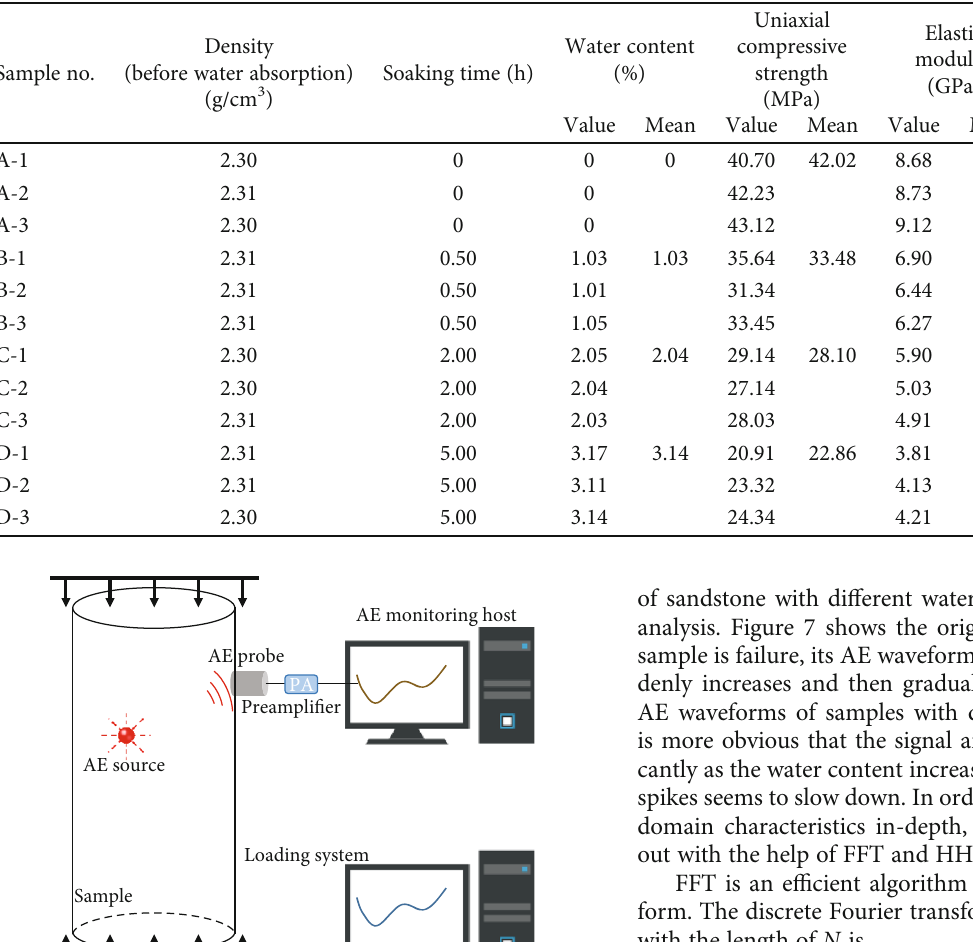
Table 1: Physical parameters and experimental results of samples.